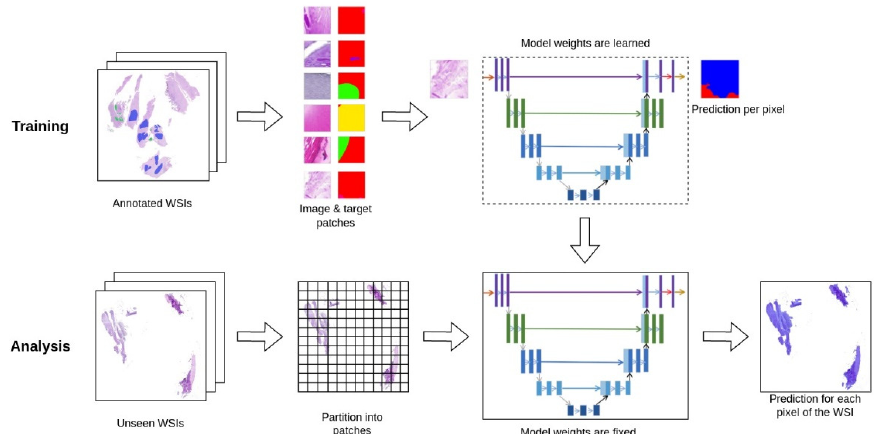
Figure 1. Scheme of the U-NET deep-learning architecture. Demonstrated is the workflow of training our model and using it for analysis. To train our model, we start with WSIs with sparse polygon annotations created by dermatopathologists. The annotations are processed into image and target examples of constant size. These examples are used to train our U-NET segmentation model, which learns to predict either ‘Tinea" or "Not Tinea" for every pixel in the input patch. During this process, the weights of the model are adjusted to improve predictions on training data. To use our model for analysis, we split a WSI into patches and serve each patch to the model to get a prediction. In this process, the model weights are fixed because it is not learning anymore. This also means that the model will give the same prediction for the same input patch. The predicted patches are stitched back together into an image of the same size as the original WSI, so they can be overlaid and used by pathologists to aid them in their diagnosis. Table 2. Per pixel evaluation. Exact number of predicted pixels can be seen in the two columns. In bold, we highlight correct predictions. Tinea Other Total Recall